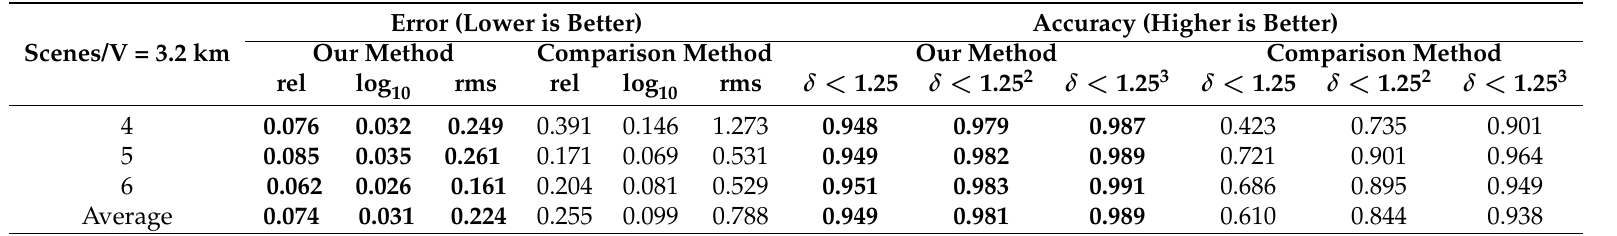
Table 4. Error and accuracy metrics of the second quantitative comparison method (V = 3.2